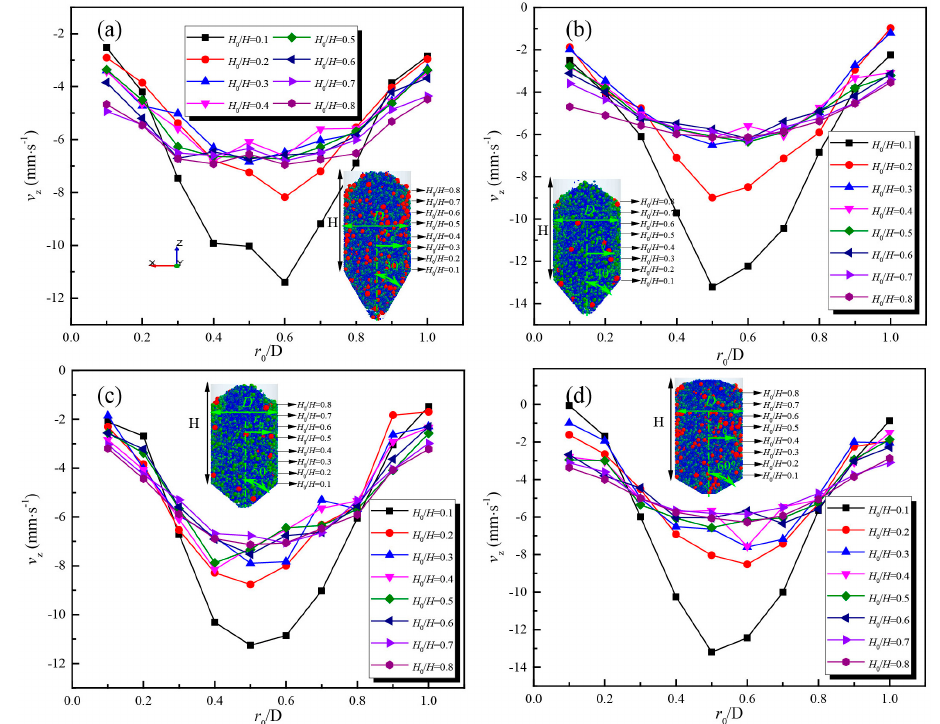
Figure 16. The variation in velocity profiles of sinter layers for different half hopper angles of ( a ) 30°, ( b ) 40°, ( c ) 50°, and ( d ) 60°.